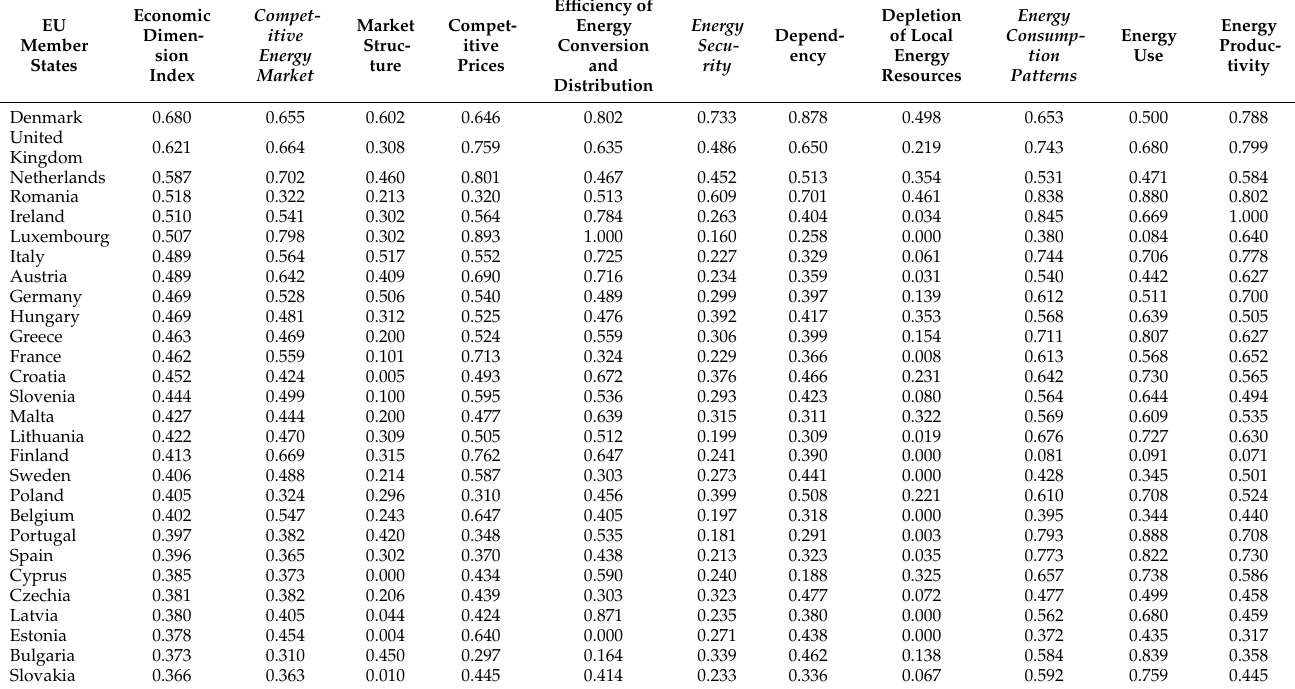
Table 4. Results in economic dimension partial